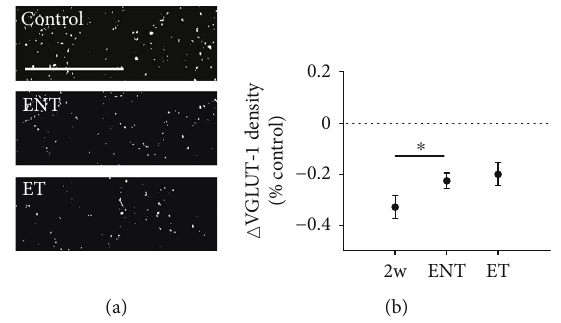
Figure 7: Tinnitus animals exhibit similar recovery of VGLUT-2 labeling relative to no-tinnitus animals in the granule cell layer of the dentate gyrus. (a) Representative images of VGLUT-2 labeling from granule cell layer of the dentate gyrus at 400x magni fi cation. Scale bar = 50 μ m . (b) Mean ( ± SEM) change of VGLUT-2 density (normalized to respective control) in the DG in two-week and 12- week postnoise-exposure animals. Compared to 2-week postexposure animals (2w), 12-week postexposure animals (ENT and ET) signi fi cantly recovered towards baseline levels (only ENT signi fi cant). Animal exhibiting tinnitus (ET) showed similar pattern of recovery in VGLUT-2 expression to animals resistant to tinnitus in the granule cell layer of dentate gyrus. ∗ p ≤ 0 : 05